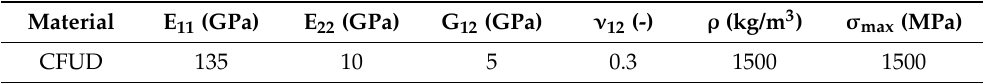
Table 6. Wingbox masses and their variation w.r.t. ISO10 solution for the baseline aircraft.